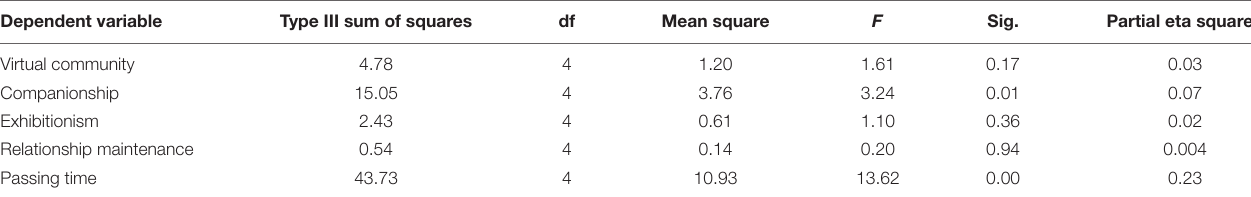
TABLE 4 | Tests of between-subjects effects for generational